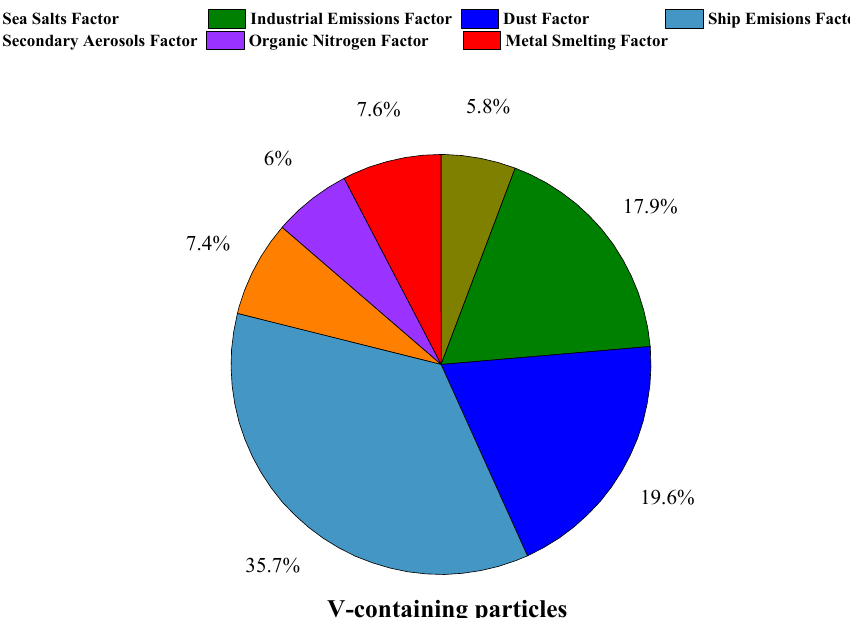
Figure 7. The fractions of the PMF factors in the V-containing particles.